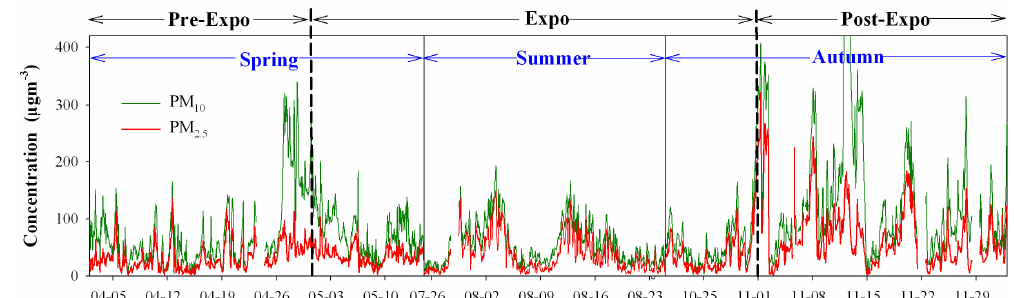
Fig. 2. Time series of hourly PM 2 . 5 and PM 10 concentrations (µgm − 3 ) measured in Shanghai during 2010. The study period spans from spring (2 April–14 May) to summer (25 July–24 August) and autumn (20 October–29 November) as marked by the blue lines in the figure. Pre-expo (before 1 May) and post-expo (after 30 November) periods are separated from the expo period in the figure marked by the black Figure 2. Time-series of hourly PM 2.5 and PM 10 concentrations ( μ gm -3 ) measured in Shanghai during 2010. The study period spans from spring (April 2 - May 14), summer (July 25 - August 24) to autumn (October 20 - November 29) as marked by the blue lines in the figure. Pre-Expo (before May 1) and post-Expo (after November 30) periods are separated from the Expo period in the figure marked by the black lines.